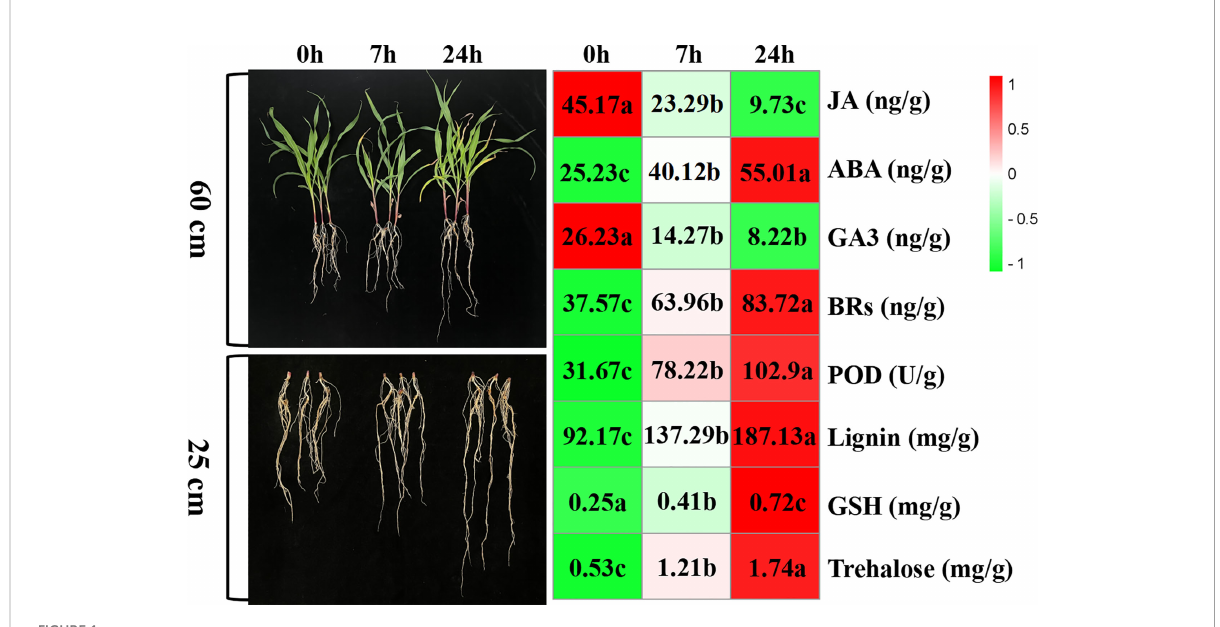
FIGURE 1 The morphology and physiochemical changes of maize variety “ M8186 ” under drought stress. Values followed by different lowercase letters represent p ≤